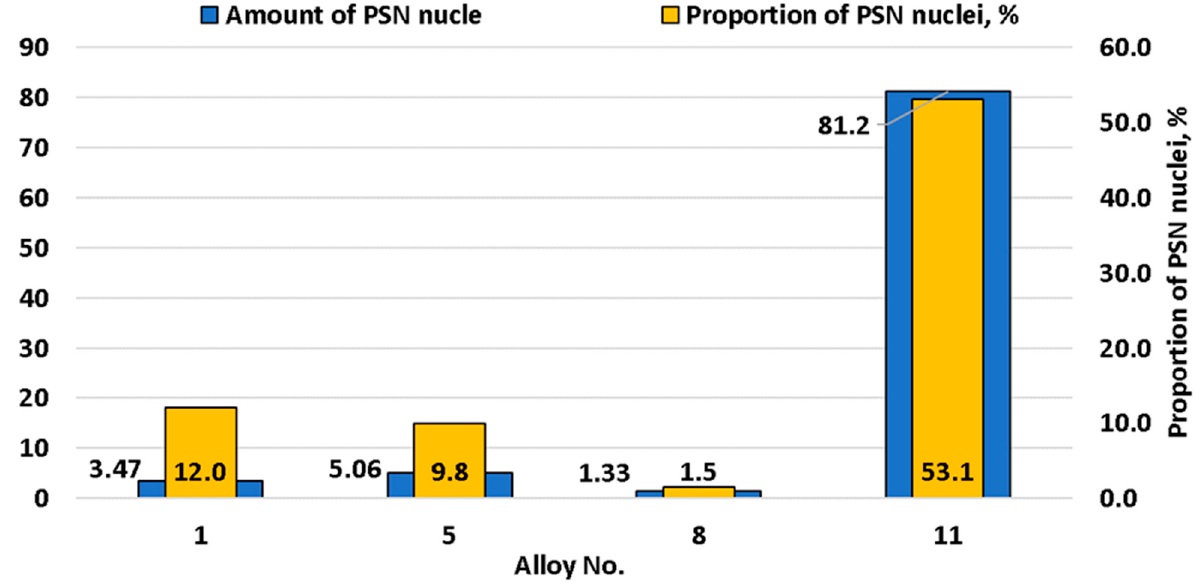
Figure 13. Change of PSN nuclei number depending on alloy chemical composition.